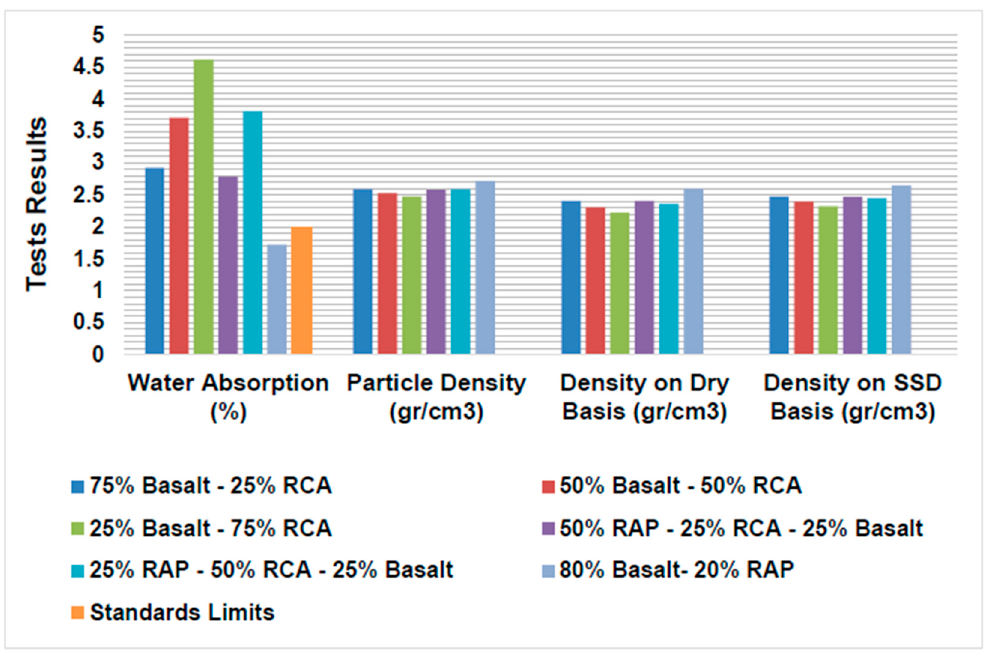
Figure 14. Comparison of Water Absorption and Particle Density of Different Mixes of Coarse Aggregates.